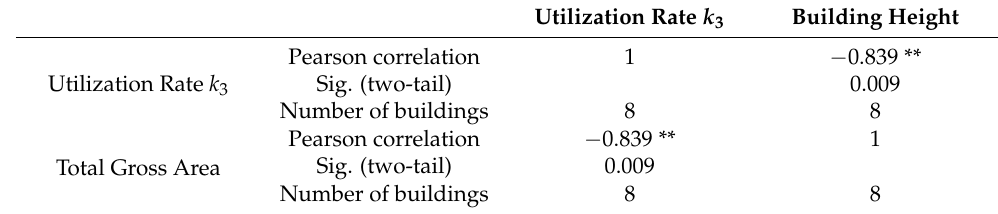
Figure 29. Relationship between total gross area and the building utilization rate k 3 . Table 9. Correlation between building height and the building utilization rate k 3 . Table 10. Correlation between total gross area and the building utilization rate k 3 .